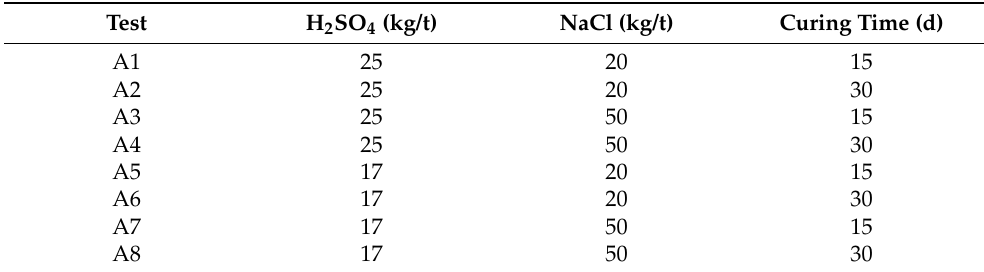
Table 3. Pretreatment tests